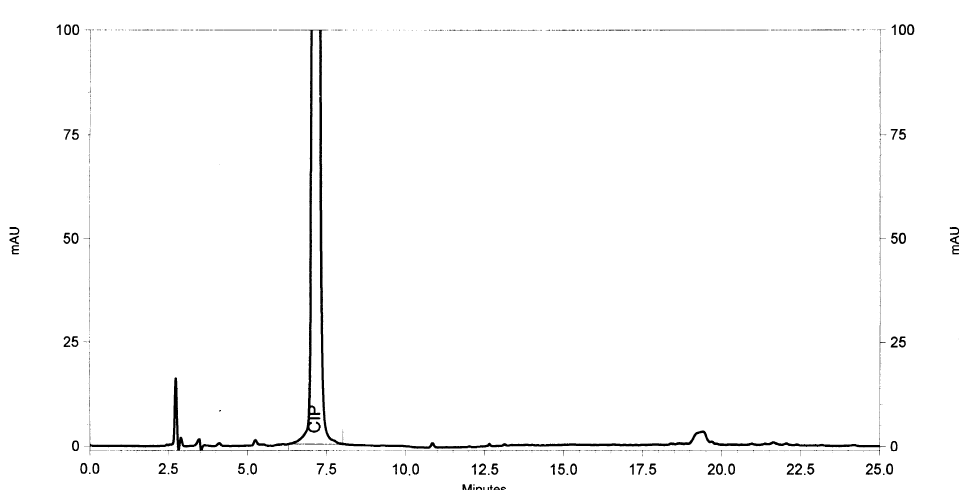
Figure 10. Chromatogram of the PEF oxidized by H 2 O 2 after incubation for 56 days at room temper- ature. 3.3. Kinetic Evaluation On the basis of a highly significant correlation demonstrated by the analysis of the plots [1/c = f(t)] for both the oxidation of CIP and PEF while using ACVA it was stated that the oxidation process followed the kinetics of second-order (Figure 11); moreover, the degradation rate constant k and the half-life t 0.5 were calculated for all examined condi- tions. The obtained results confirmed that the rate of the oxidation process is dependent on the type of FQs tested, and the temperature (Table 3).